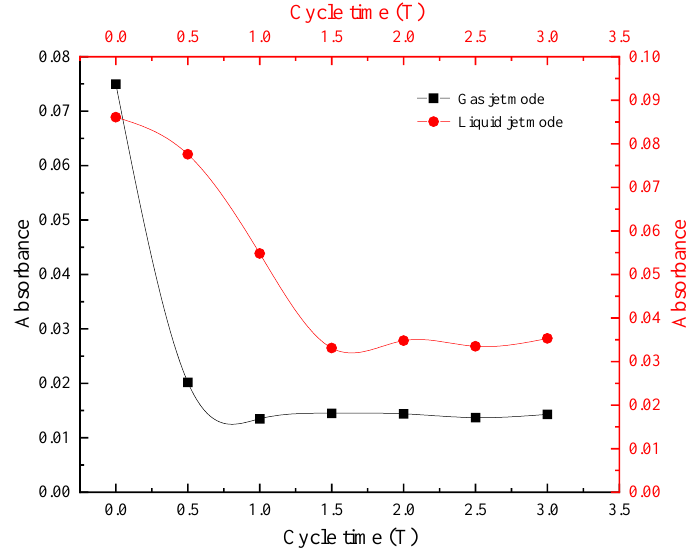
Figure 11. Influence of different coal pulp cycle times on reagent adsorption.